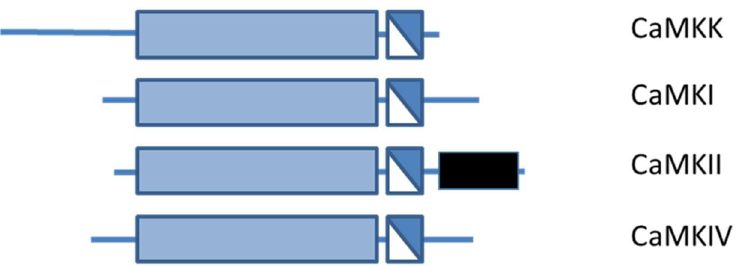
Figure 3. The general structure shared by the CaM-kinases. The N-terminal catalytic domain is represented in light blue, followed by a regulatory region containing in white the autoinhibitory domain and in dark blue the CaM-binding domain. The black block shows the C-terminal association domain of CaMKII. Adapted from Beghi S, et al., 2020 [39].